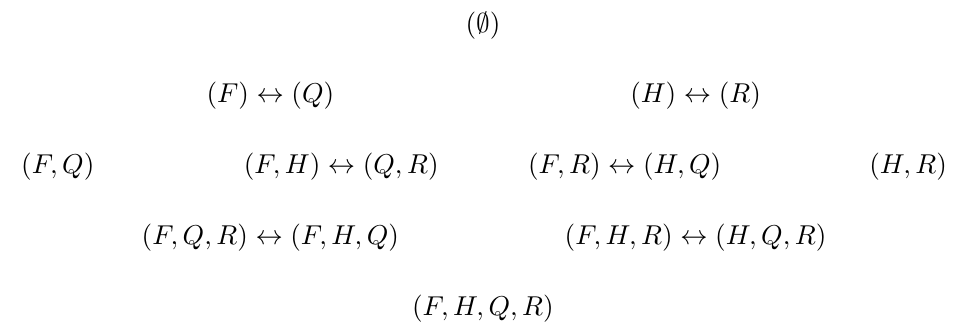
Figure 1 . Diamond representing the possible (sub)orbits. Arrows relate orbits connected by rigid T -transformations. The orbits at the four corners of the diamond are self-dual under rigid T -